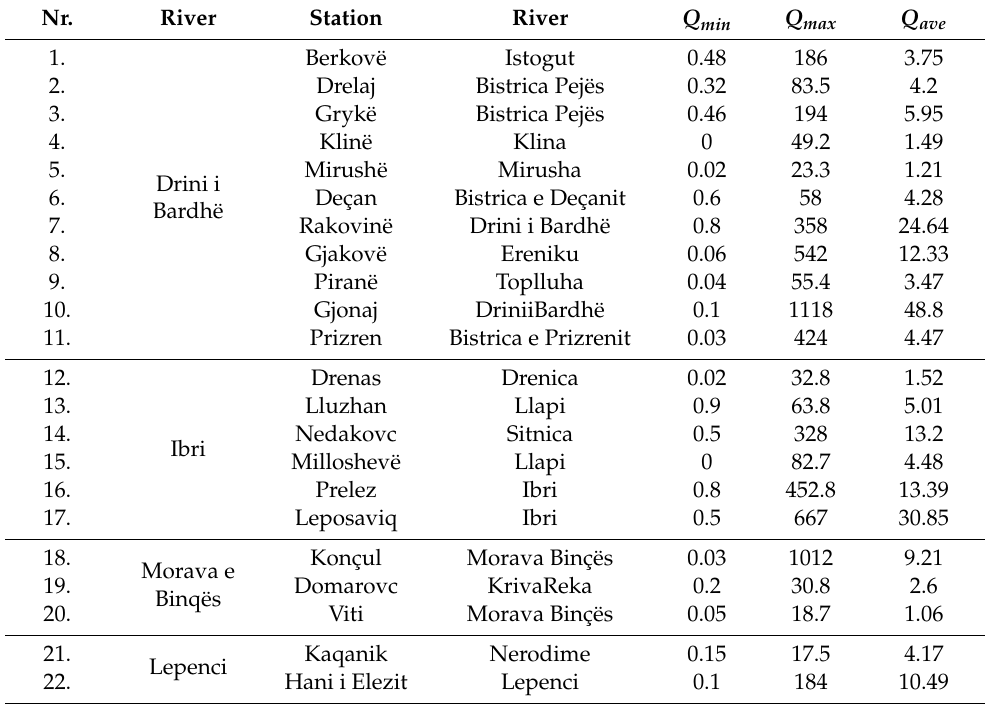
Table 4. Maximum, minimum and average values of flow rate in m 3 / s measured in hydro meteorological stations in the Republic of